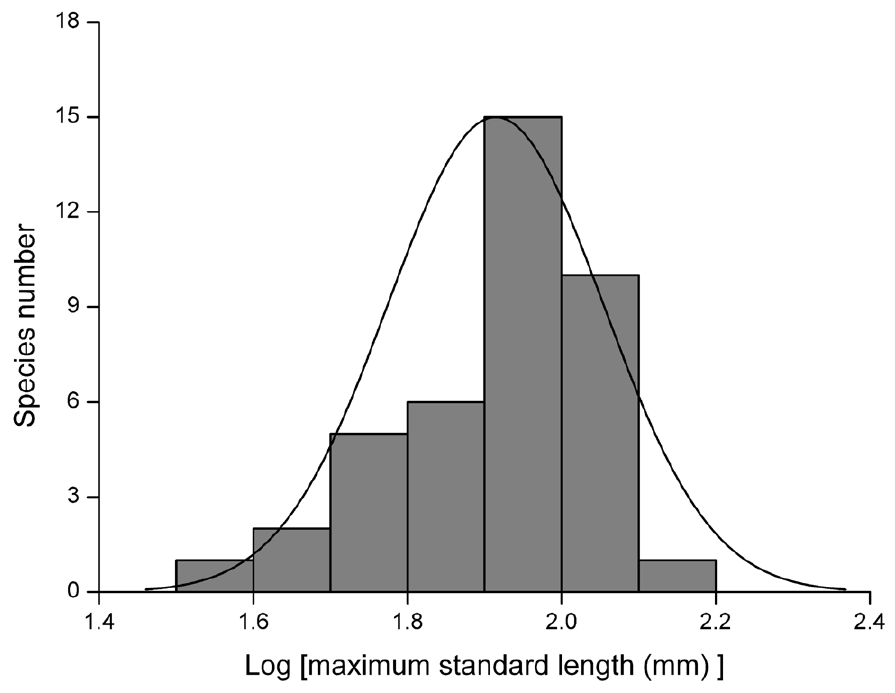
Figure 7. Frequency distribution of log maximum snout to vent length for spiny frogs ( n =41).